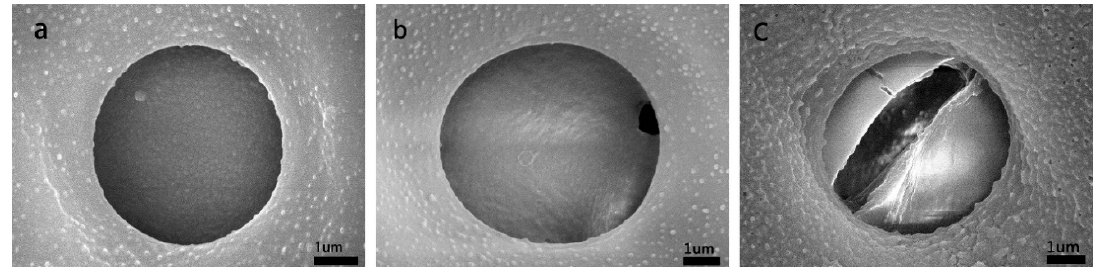
Figure 1. Scanning electron microscopy (SEM) micrographs of bordered pits under different microwave (MW) intensities: ( a ) Control, ( b )low ‐ intensity, ( c )high ‐ intensity.